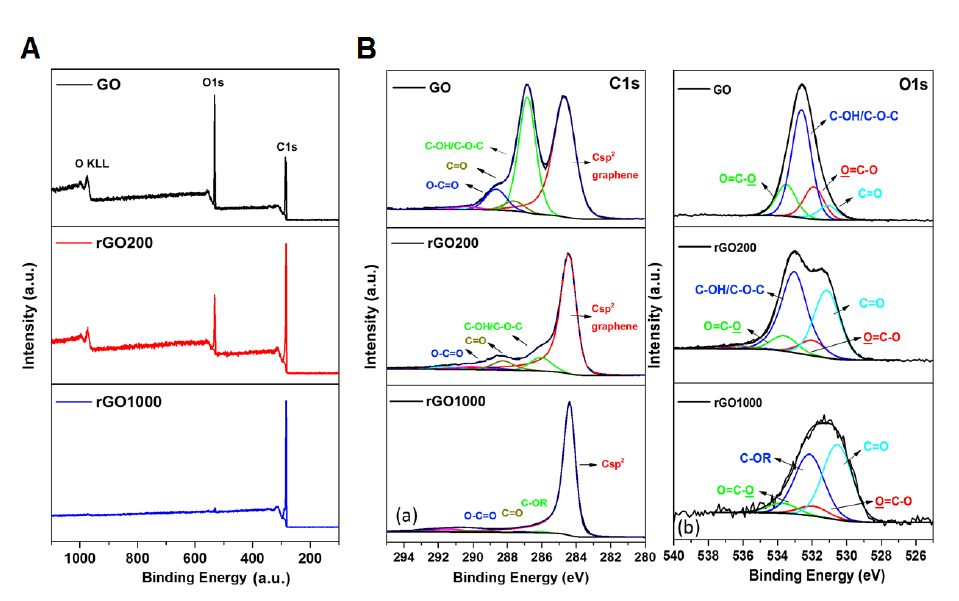
Figure 2. X-ray photoelectron spectroscopy (XPS) survey spectra of GO, rGO200 and rGO1000 materials ( A ); C1s and O1s deconvoluted XPS spectra for GO, rGO200 and rGO1000 ( B ).